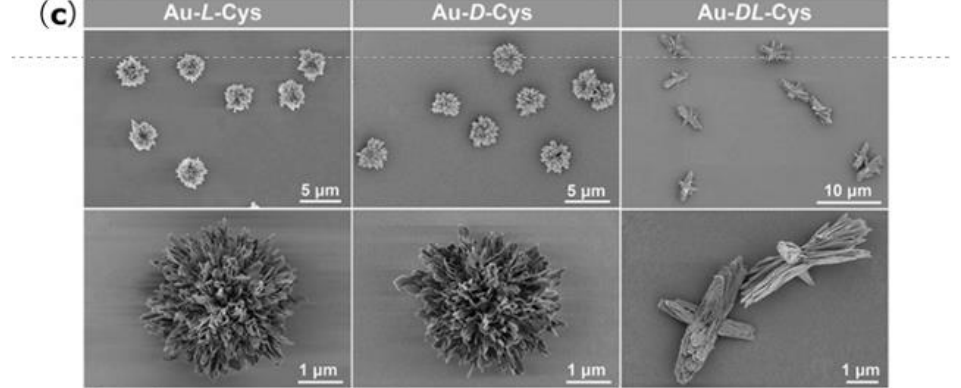
Figure 1. ( a ) SEM images of a rhombic dodecahedral shape under different cysteine concentrations ranging from 0.1 to 0.3 mM (reproduced with copyright permission from [17], Springer Nature). ( b )